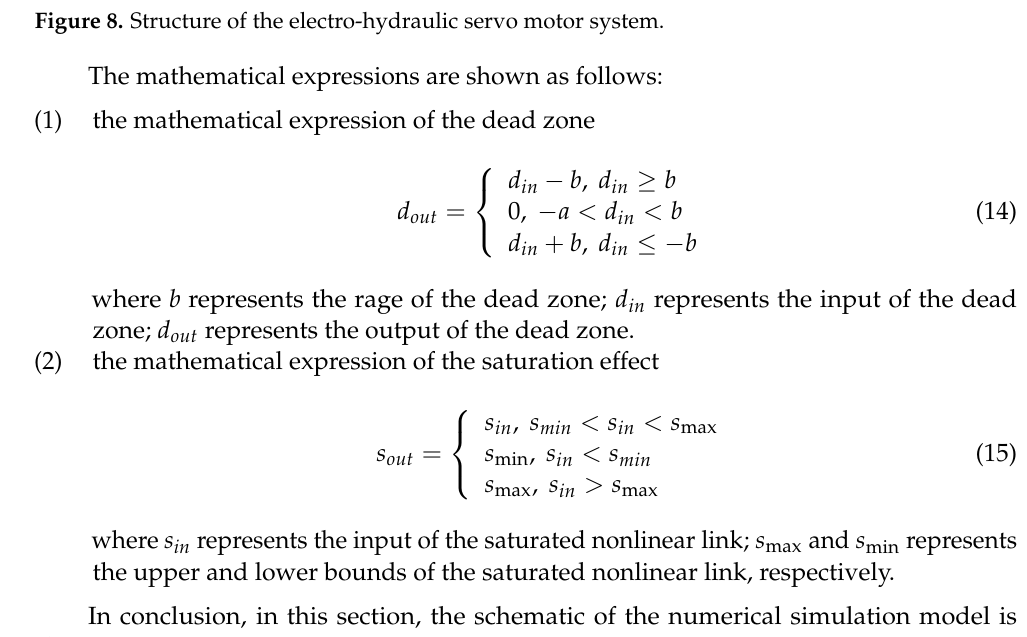
Figure 8. Structure of the electro-hydraulic servo motor system.